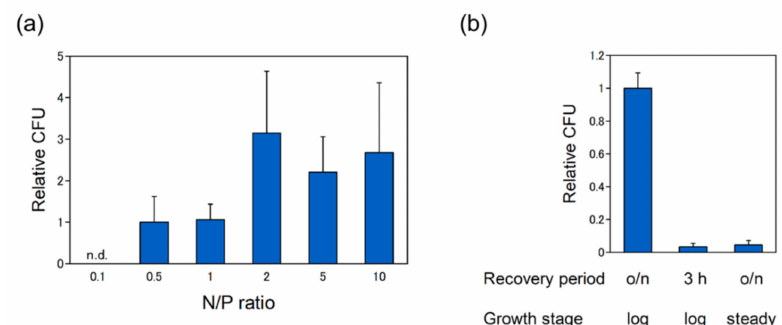
Figure 4. Optimization for the pDNA delivery into R. sulfidophilum cells. ( a ) E ff ect of N / P ratio on the e ffi ciency. The pDNA complexes was prepared using a fixed amount of pDNA (1 µ g) at N / P ratio 0.1, 0.5, 1, 2, 5 and 10. The data were normalized by ‘N / P ratio 0.5 (cid:48) . n.d., not detected. ( b ) E ff ects of recovery period and cell growth stage on the delivery e ffi ciency. The log phase (OD 660 of around 1.0) cells and the stationary phase (OD 660 of around 4.0) cells were used for experiments. The concentration of dTat-Sar-EED5 was fixed to 100 µ M. Data are the mean ± SD of at least three cultures. The data were normalized by ‘o / n recovery period and log phase cells’